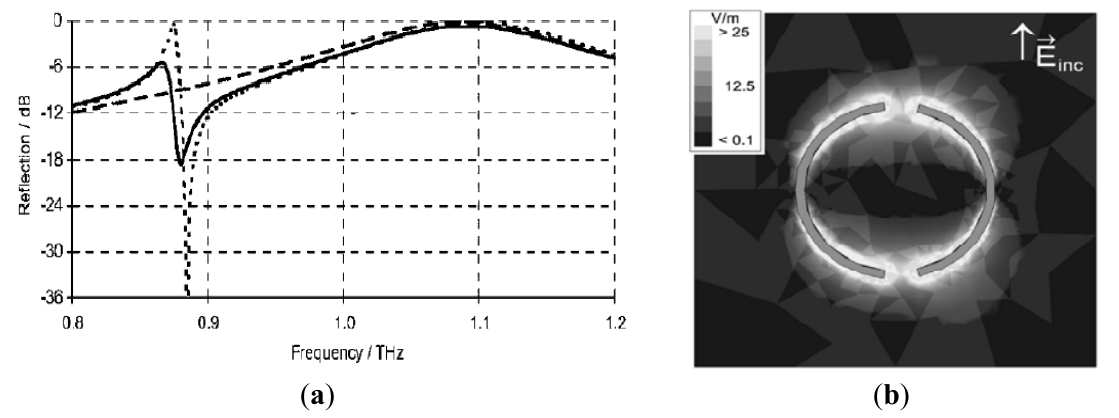
Figure 4. ( a ) Reflection of FSS of symmetric (dashed line) and asymmetric DSRs with φ = 4° for a perfect conductor (dotted line) and for gold (solid line); ( b ) The E -field in the resonator plane shows a strong concentration (white) at the ends of the arcs. f = 875 GHz, amplitude of excitation 1 V/m [48].